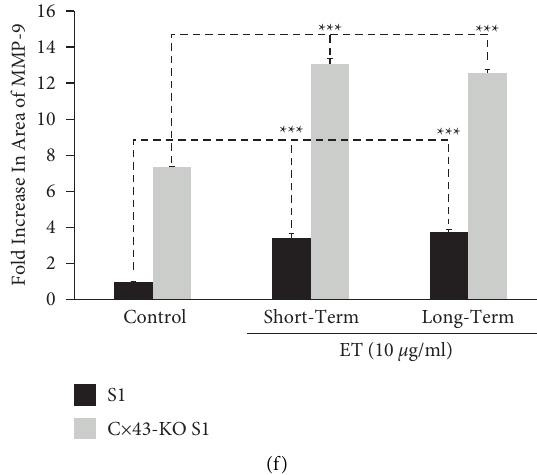
Figure 4: Pretumorigenic Cx43-KO S1 human breast epithelial cells secrete higher levels of MMP-9, and their invasive ability is enhanced upon endotoxin exposure more than their nontumorigenic S1 counterparts. (a) Short-term and long-term exposures of S1 and Cx43-KO S1 cells to 10 µ g/ml ETenhanced the invasion across Matrigel. Scale bar is 10 µ m. (b) Fold increase in the number of invading cells subjected to short-term and long-term ETtreatment at 10 µ g/ml ETrelative to untreated controls (0 µ g/ml). (c) Gelatin zymography of untreated S1 and Cx43-KO S1 media collected from 2D cultures upon reaching 75% confluence showed upregulation of MMP-9 activity in Cx43-KO S1 compared to S1 cells. (d) Quantification of fold increase in peak area of MMP-9 bands shown in the previous zymogram, corrected for the 30% increase in cell counts observed with Cx43-KO S1 compared to S1 cells. (e) Gelatin zymography and (f) quantification of fold